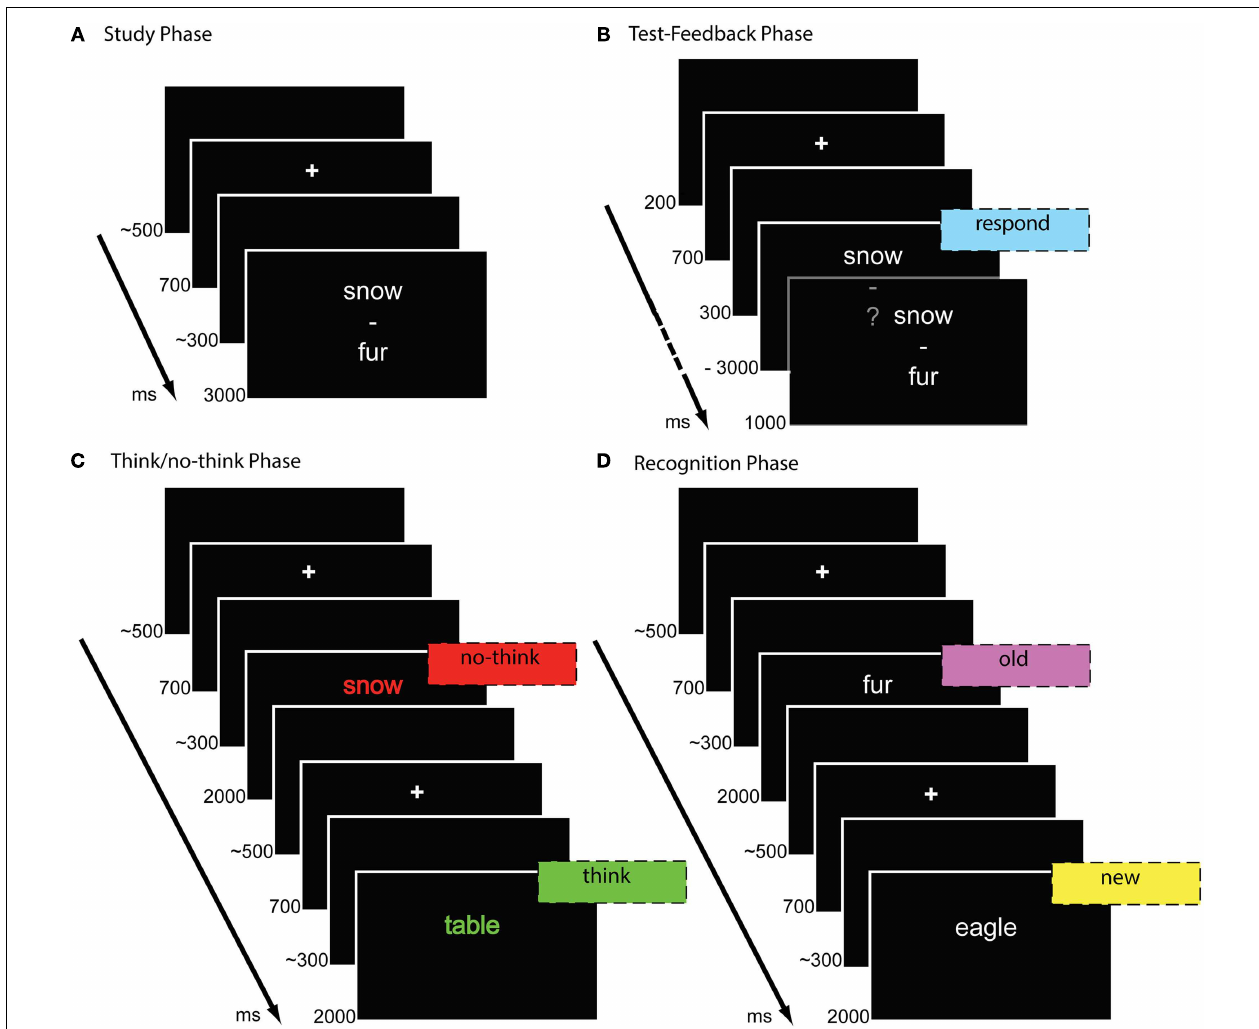
FIGURE 1 |Trial procedures in the different phases of the think/no-think experiment comprising study phase (A), test-feedback-cycles (B), think/no-think phase (C), and recognition test